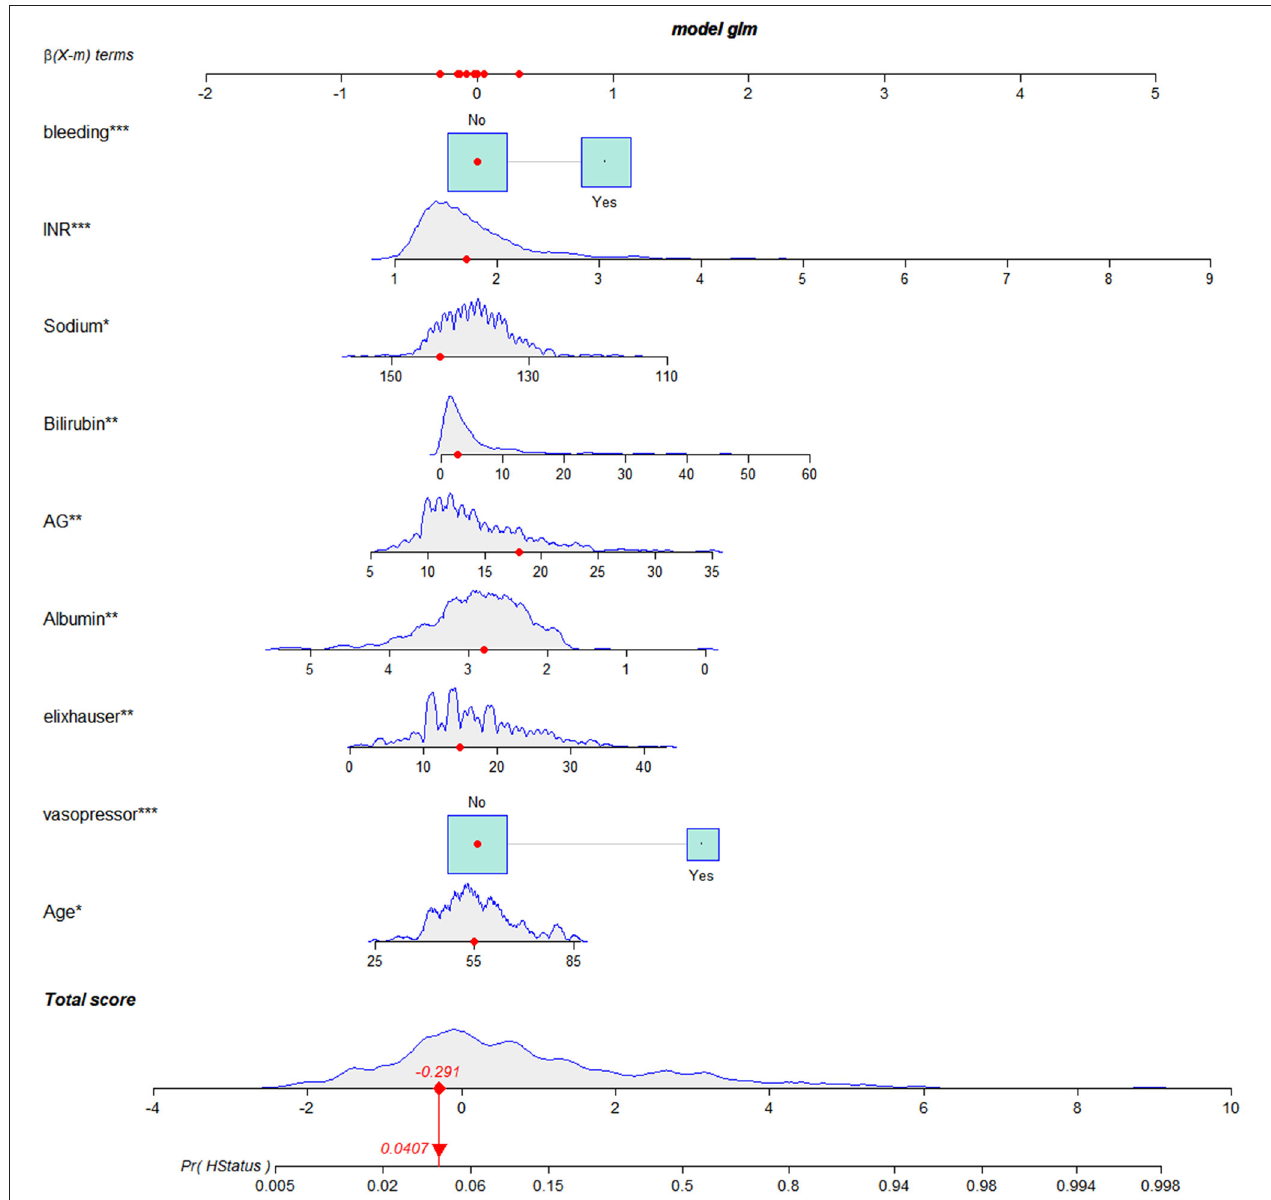
FIGURE 2 | Nomogram for predicting in-hospital death in LCEV patients. LCEV, liver cirrhosis with esophageal; GCS, Glasgow Coma Scale; BUN, blood urea nitrogen; AP, alkaline phosphtaase; INR, international normalized ratio; SpO 2 , percutaneous oxygen saturation; HCC, hepatocellular carcinoma. * P < 0.05, ** P < 0.01, *** P <